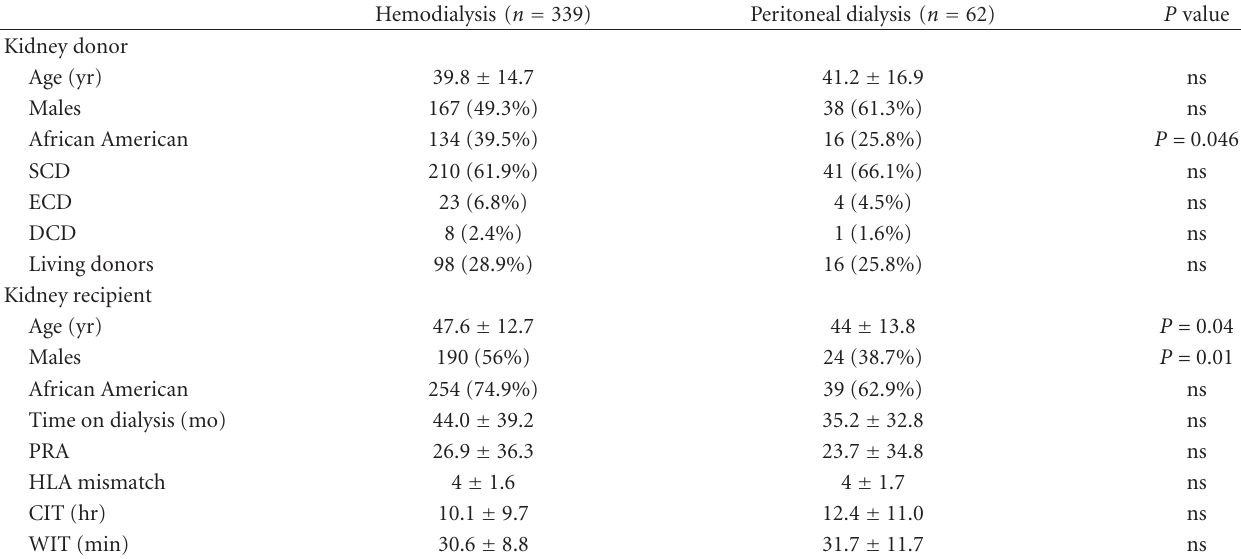
Figure 1: Graft (a) and patient survival (b) curves in peritoneal (PD) and hemodialysis (HD) groups. By Mantel-Cox log rank test, there was no di ff erence in graft ( P = 0 . 51) or patient ( P = 0 . 52) survival. Table 1: Donor and recipient